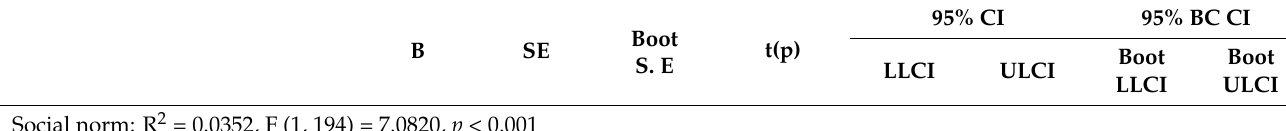
Table 2. Direct and moderating effects of transformational leadership, social norms, and team cohesion.